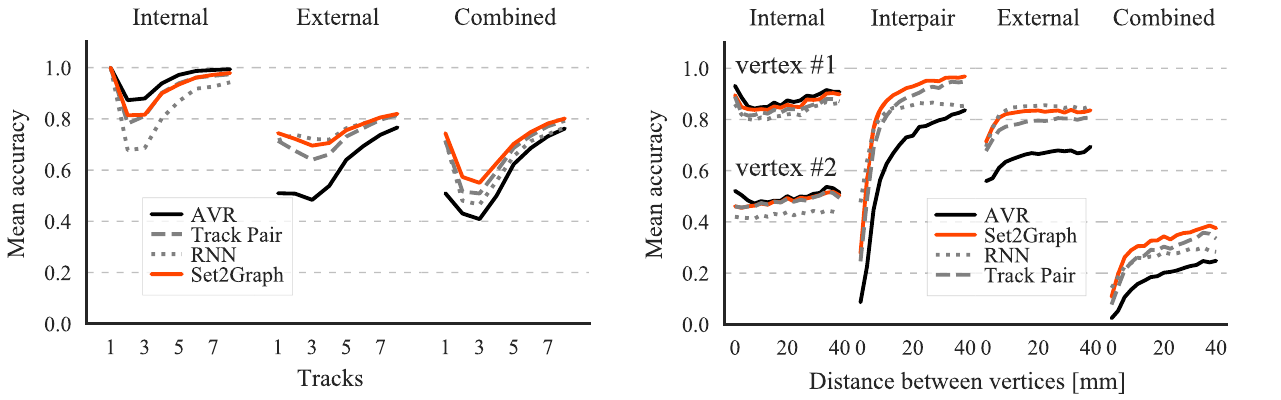
Table 3 Jet flavor classification performance metrics. The model with pre-trained S2G vertex finding module outperforms the other algorithms in overall